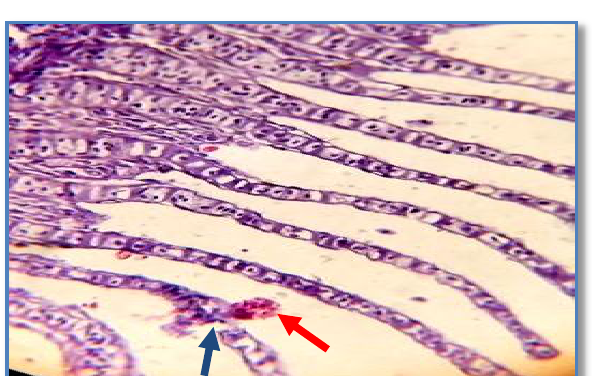
Figure, 3: Sagittal section of filament during summer season showing lamellae rupture of lamellae ( ) with hemorrhage of blood channels ( ), (X400 PAS